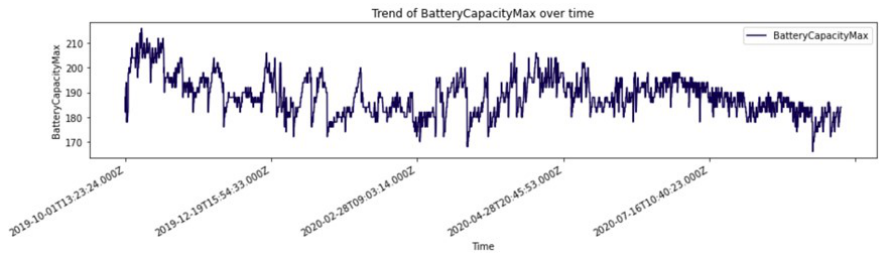
Figure 6. Time series plot.